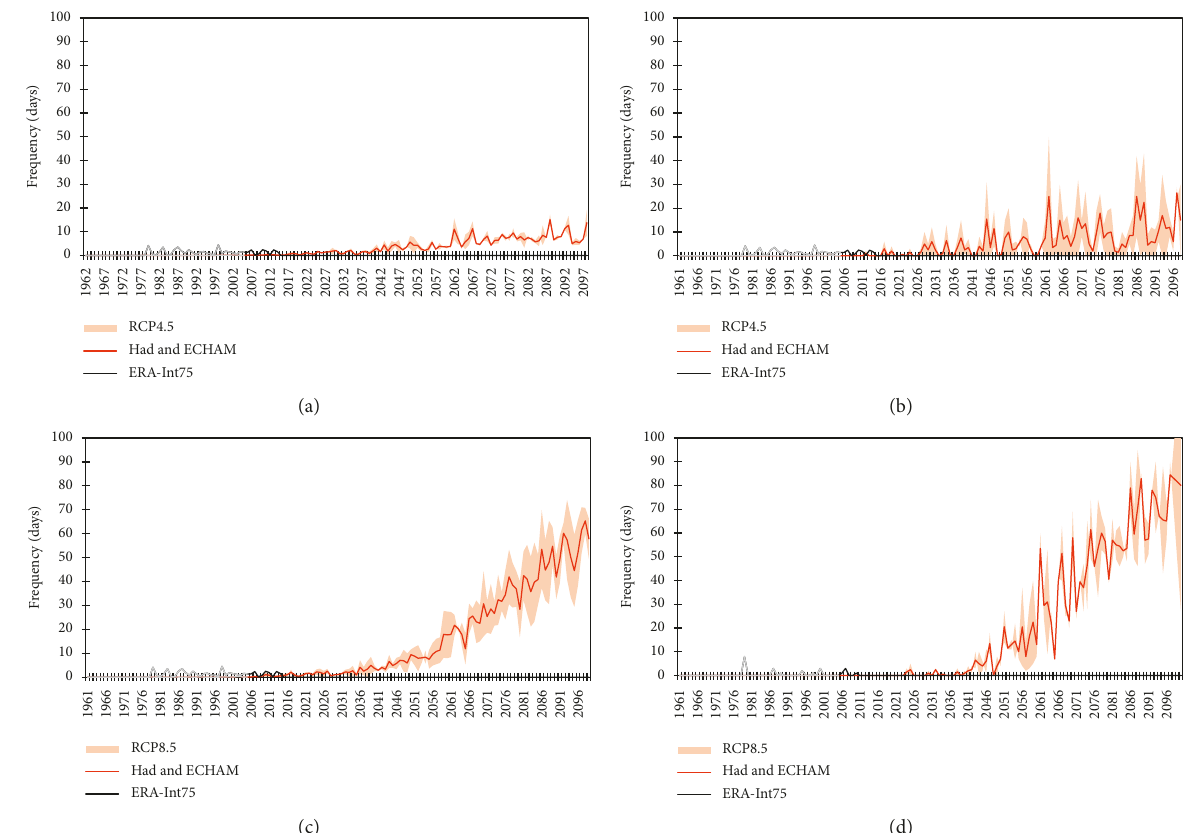
Figure 8: Number of RegCM-simulated hot days ( T ° C) for (a) CORDEX domain with RCP4.5, (b) Arabian Peninsula subdomain max ≥ 50 with RCP4.5, (c) CORDEX domain with RCP8.5, and (d) Arabian Peninsula subdomain with RCP8.5. Average is taken from HadGEM2- and ECHAM6-driven runs. Shaded area shows the range, and gray color indicates the past